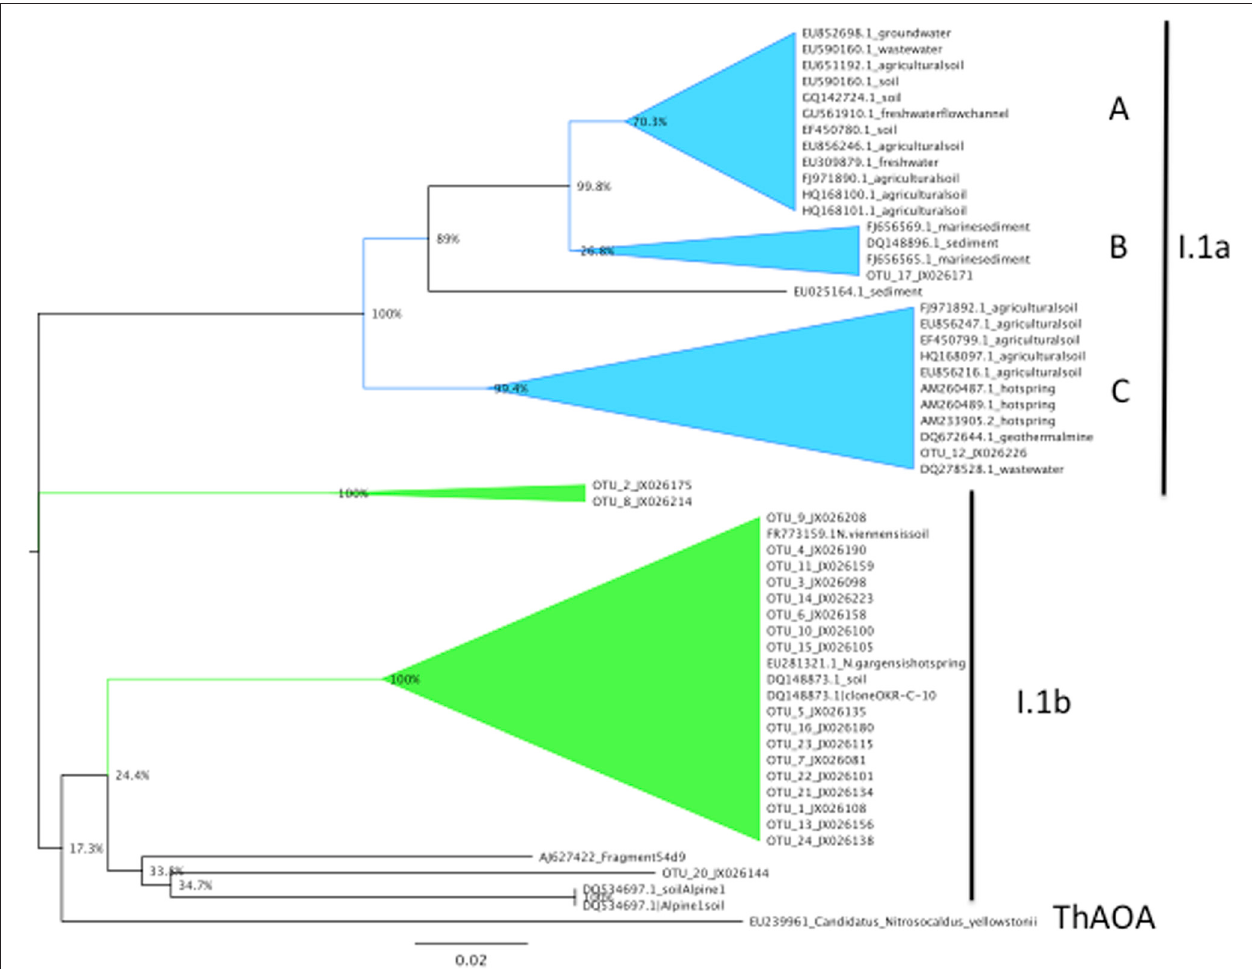
FIGURE 6 | Neighbor-joining tree of archaeal amoA sequences from the composts and reference sequences from the archaeal lineages I.1a (subgroups A, B, and C), I.1b and the thermophilic AOA (ThAOA). Bootstrap values (1000 replicates) are given at nodes.